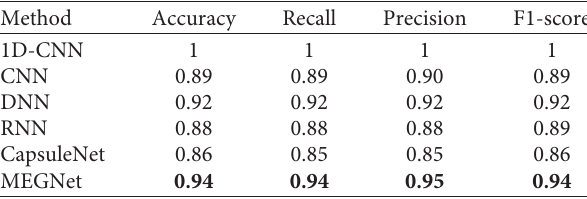
Table 2: The performance of various models was